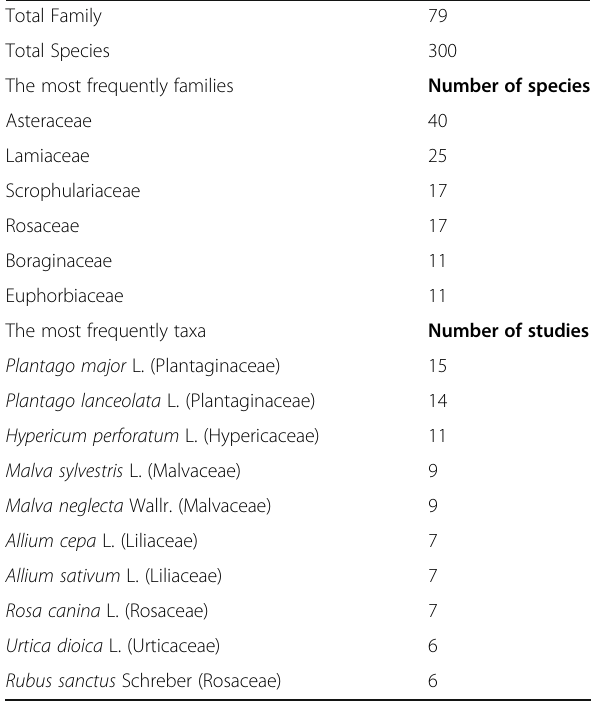
Table 2 Families and species of the plants are compiled from research